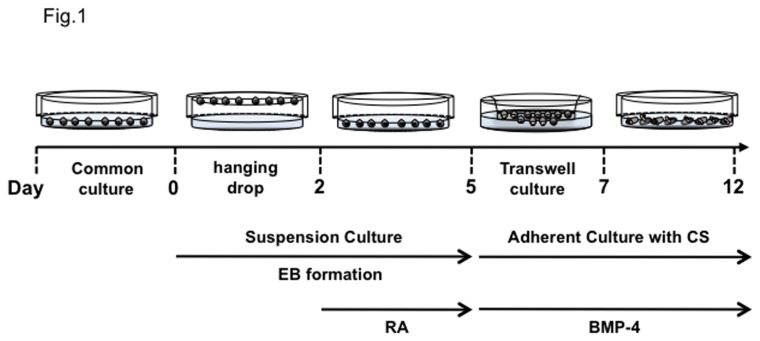
Schematic representation of the experimental protocol used for odontoblast differentiation of mouse iPS cells.EB, embryoid body; RA, retinoic acid; CS: collagen type-I scaffold.